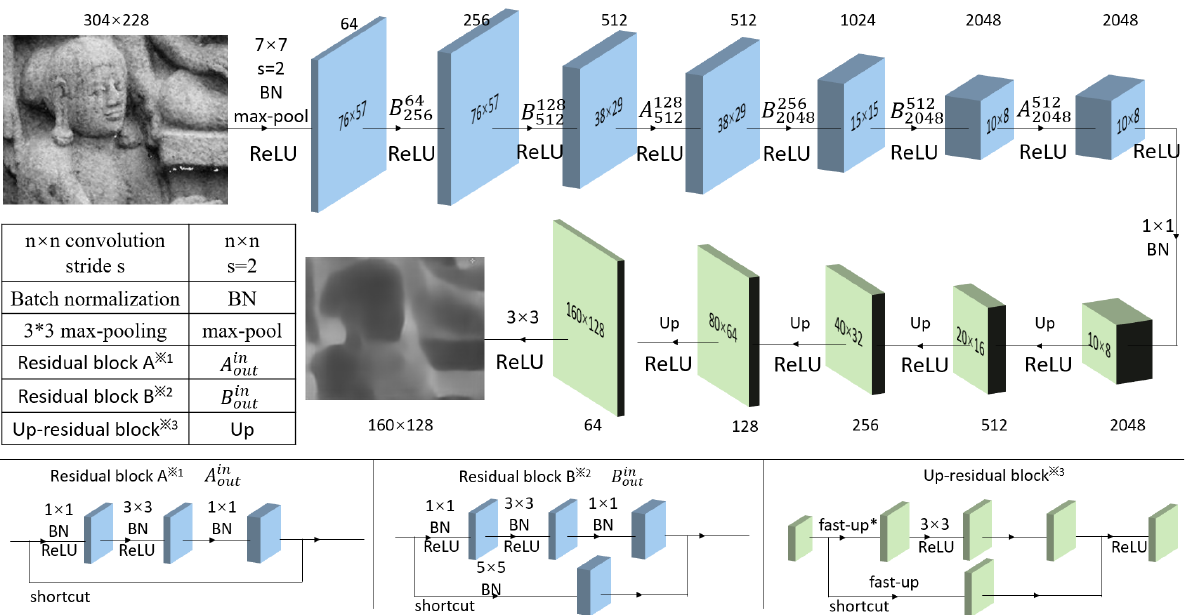
Figure 2. Network architecture of the depth estimation model. The proposed architecture applies ResNet-50 for down-sampling convolutional layers (blue parts). The fully connected layers are replaced by up-residual blocks (green parts) as described in (Laina et al., 2016). The fast-up in up-residual blocks is explained in Fig.